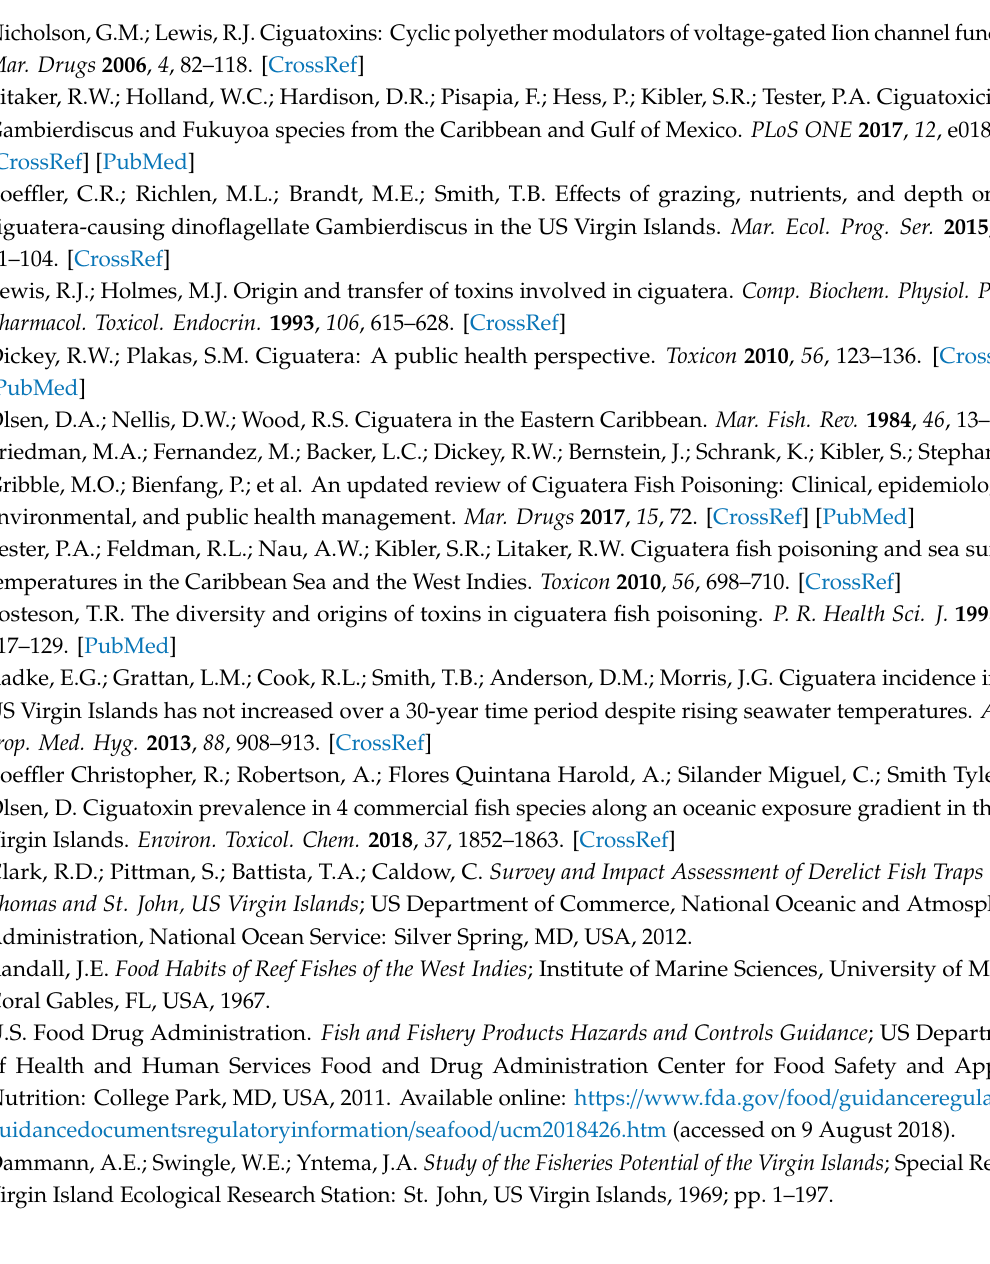
Table S1: Supplementary Table